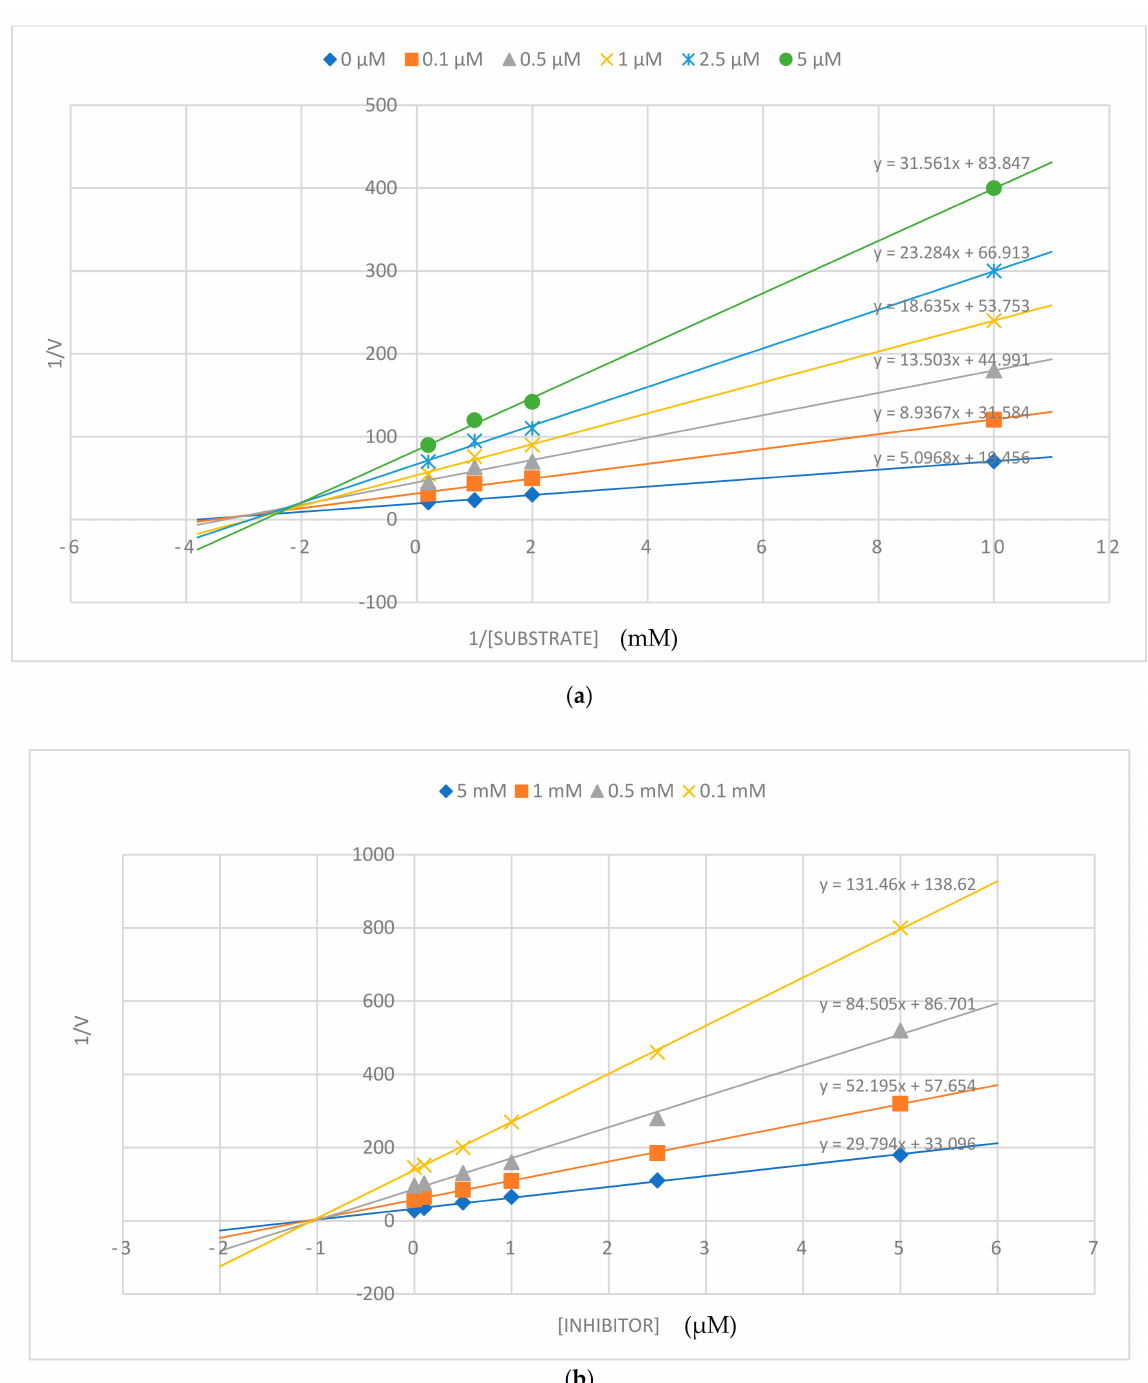
Figure 3. Lineweaver-Burk ( a ) and Dixon ( b ) plots for 2a against α